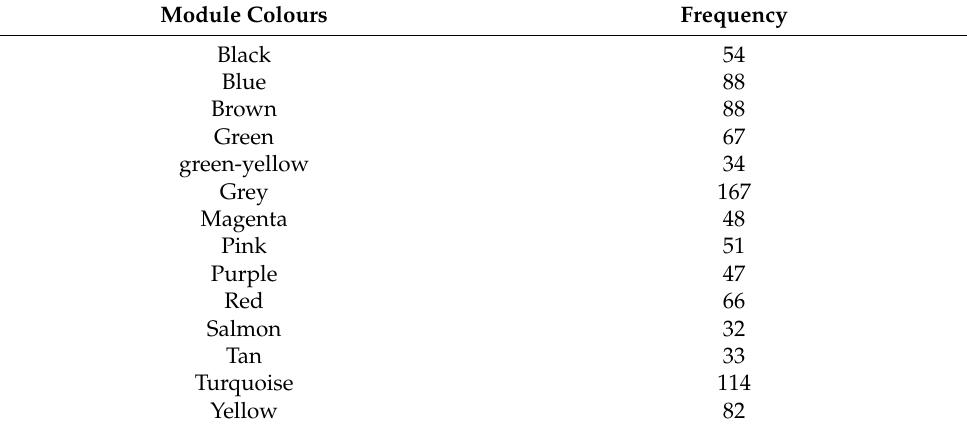
Table 2. The number of taxa in the 14